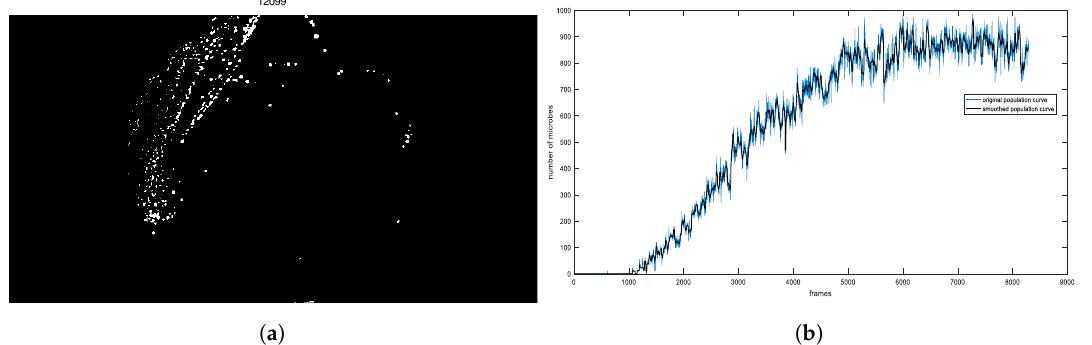
Figure 4. ( a ) The estimated number of microbes according to Equation (9) for each pixel, encoded in shades of gray. ( b ) A curve example and its smoothing effect at a random point of plate by using median